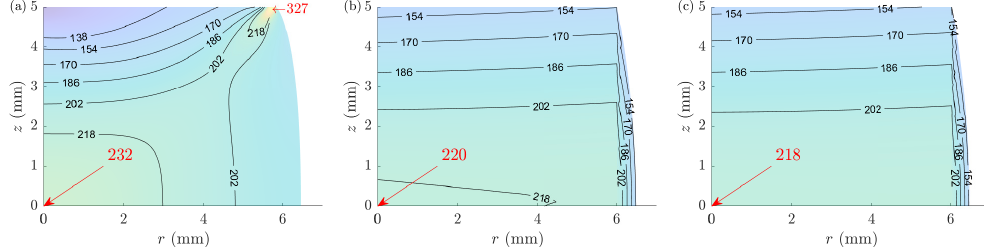
Figure 17. Comparison of the von Mises stress distributions in a randomly selected sample (#5) for ( a ) FEM and the proposed ( b ) ACTS and ( c ) ACTA models. (The presented solutions for ACTA are essentially the solutions of ACTS using the parameters identified from the ACTA analyses of the FE virtual experiments). The values are in the units of